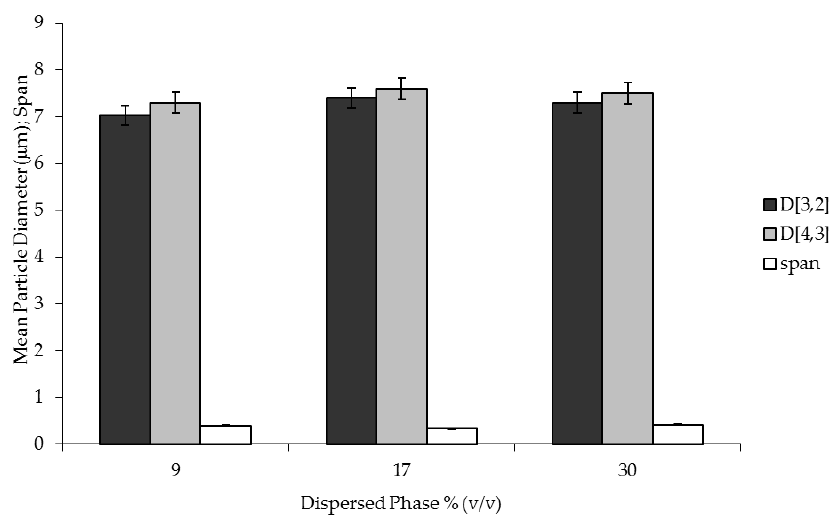
Figure 3. The effect of dispersed phase % (v/v) on particle size and particle size distribution of W/O emulsion prepared by using pulsed back-and-forward membrane emulsification (dispersed phase flux: 7.2 L h −1 m −2 ; shear stress: 5.8 Pa; membrane pore size: 3.1 µm). The average size of 7.2 µm for D [3,2] and 7.5 µm for D [4,3] with a span of 0.38 was kept constant